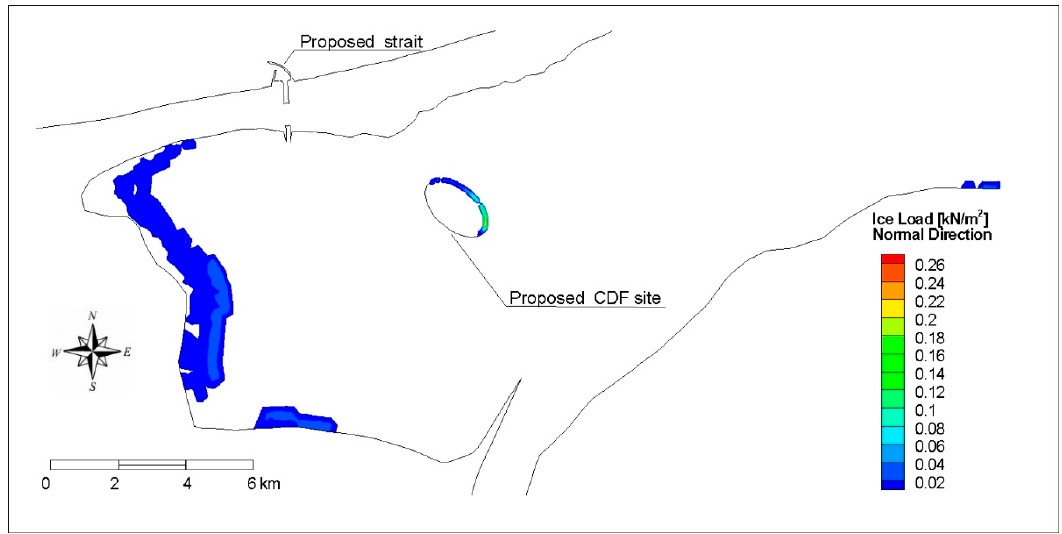
Figure 10. Simulation results of ice load on the shore of the Vistula Lagoon for the case with wind blowing from a North-East direction.